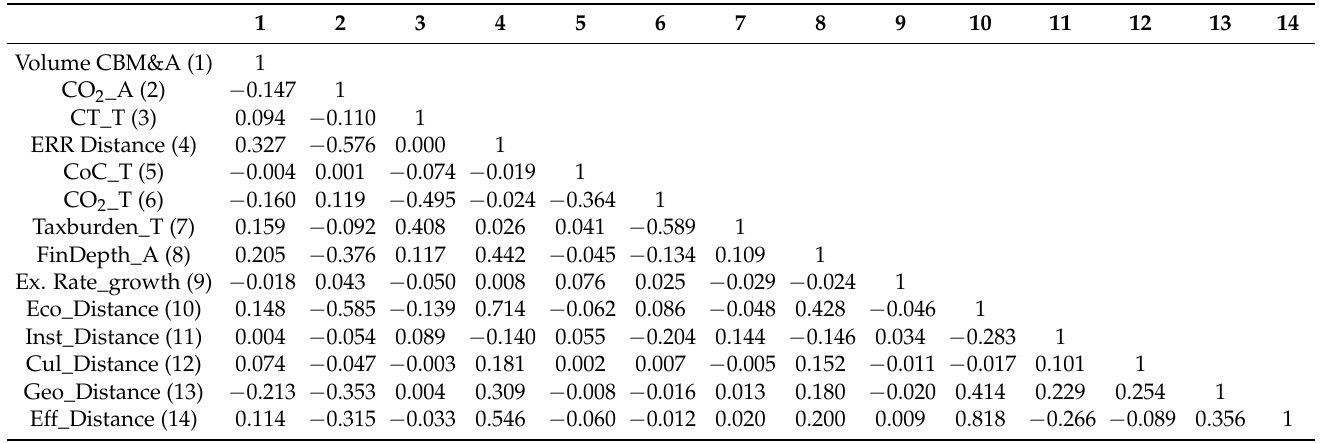
Table 2. Correlation matrix of all